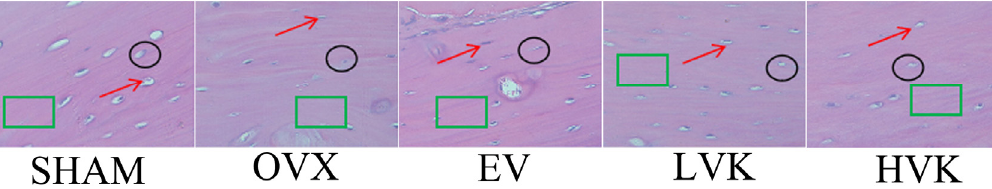
Figure 4. HE staining of compact bone in mice that were sham operated or ovariectomized and untreated or administered EV, LVK, or HVK for 12 weeks. n = 5 per treatment. The red arrows indicate bone cells, the black circles indicate the lacunae and bone matrix, and the green rectangles show osteone. EV, estradiol valerate; HVK; MK-4 40 mg/kg body weight group; LVK, MK-4 20 mg/kg body weight group; MK-4, menaquinone-4; OVX, ovariectomized group.